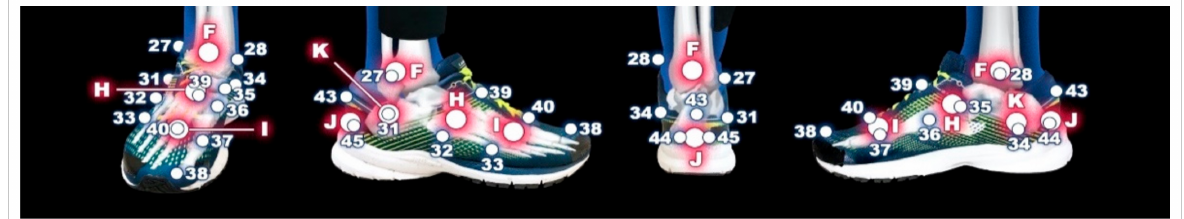
Figure 2. Marker placement multi-segmental model.